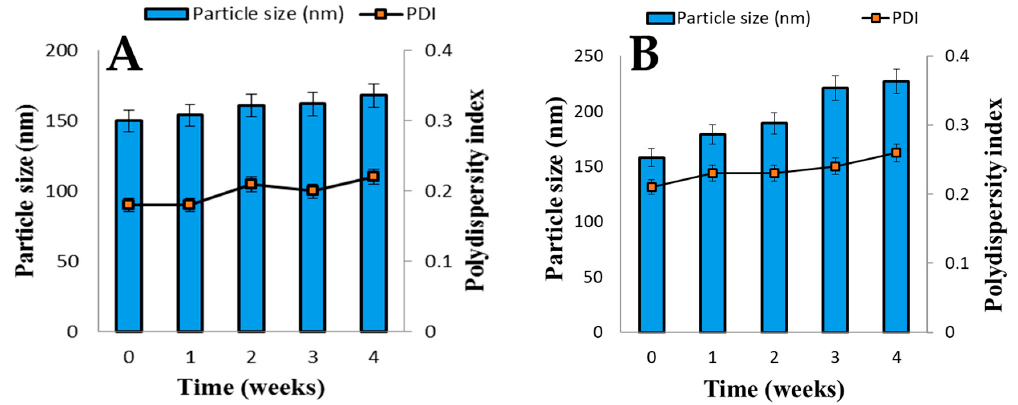
Figure 7. Change of particle size and polydispersity index (PDI) of ( A ) SCF-CO 2 liposomes, and ( B ) conventional liposomes stored at − 5 °C over time. Data are expressed as the mean standard deviation ( n = 4).